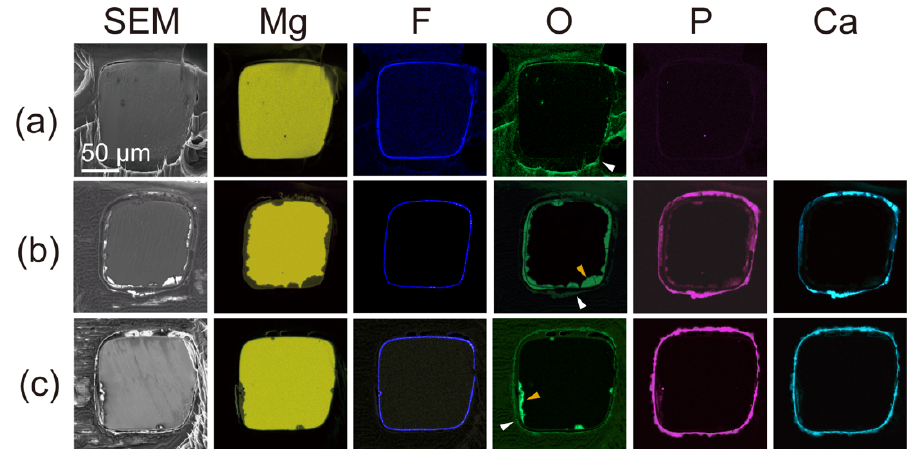
Figure 3. EDS mapping for cross-sections of parylene C and polymer-coated HF-treated stents immersed for 1 month ( a ), 6 months ( b ), and 12 months ( c ) in the cell culture medium. The white and orange arrow heads indicate O signal from polymer layer and corrosion products of the Mg alloy, respectively.